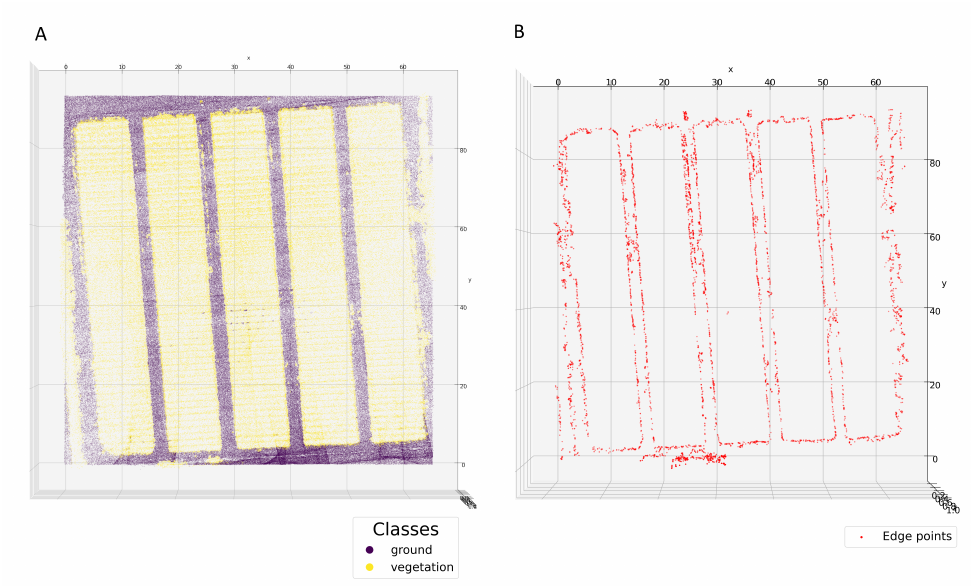
Figure 6. ( A ) Classification of the points; ( B ) Detection of edge